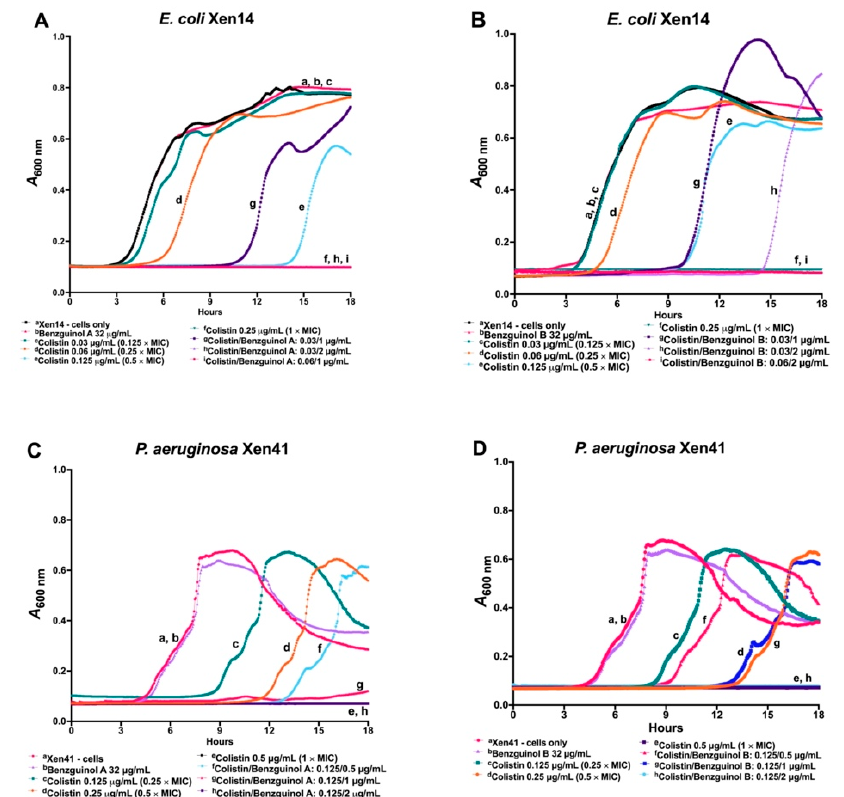
Figure 3. Time- and concentration-dependent antibacterial activities of benzguinols A and B alone and in combination with colistin. Growth inhibitory kinetics of the benzguinols alone or in combi- nation with colistin against E. coli Xen14 ( A , B ) and P. aeruginosa Xen41 ( C , D ) were performed on a Cytation 5 Multimode reader (BioTek, Millennium Science Pty Ltd, Mulgrave, VIC, Australia) by optical density ( A 600nm ) measurements.